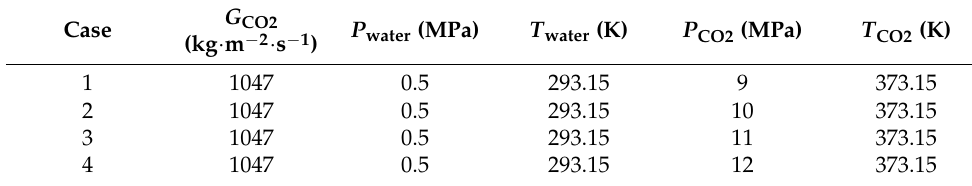
Figure 10. Effect on the heat transfer coefficient of CO 2 at different cooling pressures.